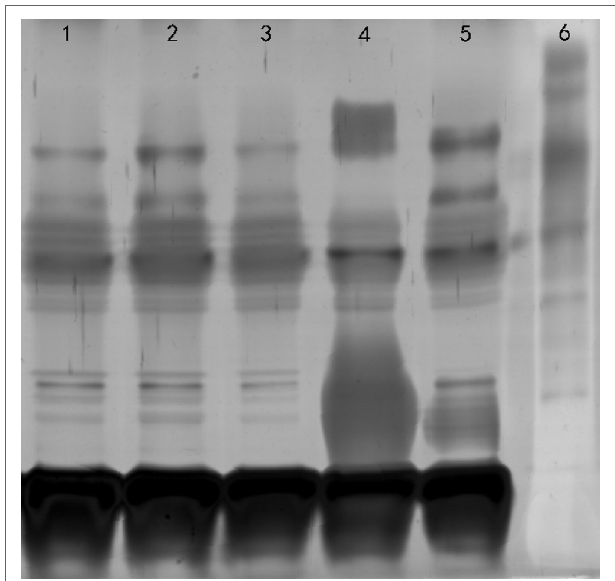
FigUre 3 | SDS-PAGE analysis of LPS. Lane 1, Brucella canis ZJ-1 (human); lane 2, B. canis ZJ-2 (dog); lane 3, B. canis RM6/66; lane 4, Brucella melitensis 16M; lane 5, B. suis 1330S; lane 6, molecular weight